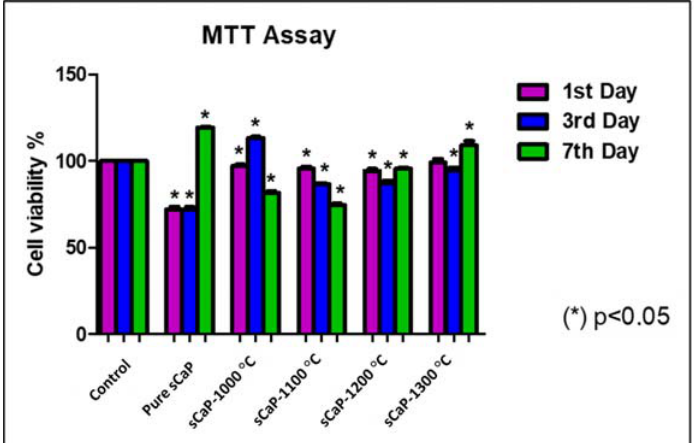
Figure 7. The cytotoxic e ff ects of sCaP-1000 / 1100 / 1200 / 1300 ◦ C on the viability of Saos-2 cells on di ff erent days obtained by MTT